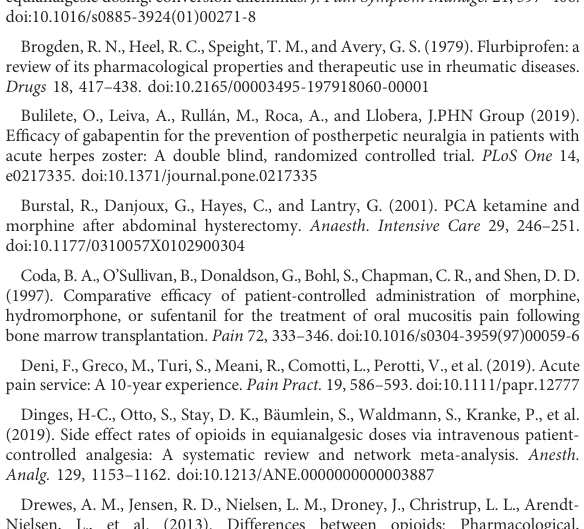
SUPPLEMENTARY FIGURE 4 Estimated incidence of the outcomes. Incidence-time curves of (A) AIS, (B) AIM, (C) PONV, and (D)